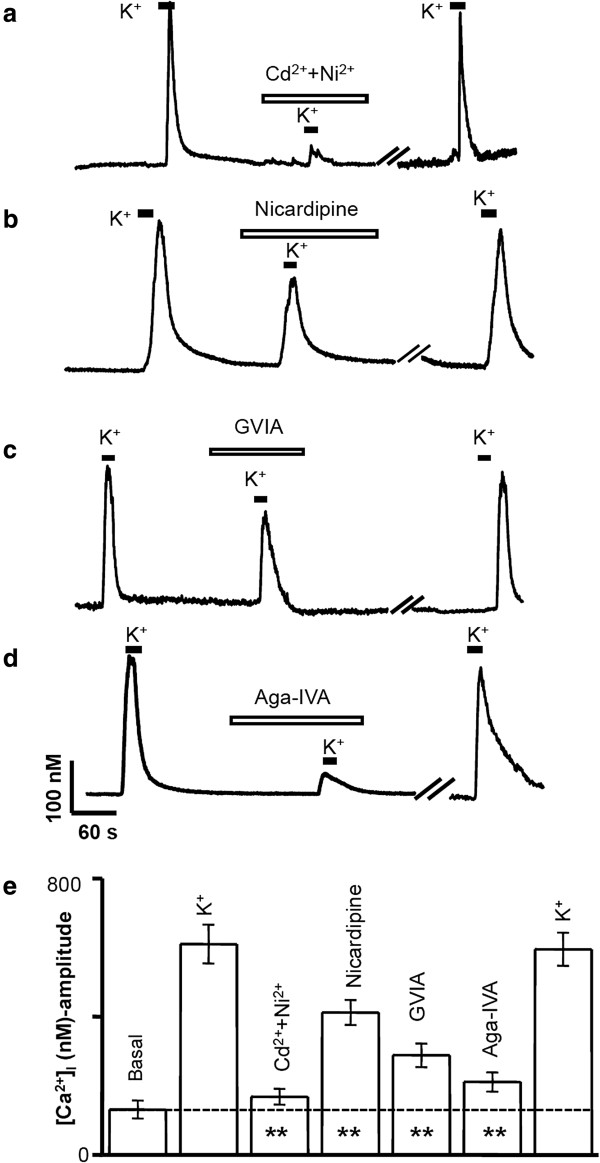
SPC-01 generates functional neurons. (a) Preincubation with Cd2+ (100 μM) together with Ni2+ (50 μM), for 5 minutes significantly reduced the [Ca2+]i responses induced by K+ in all cells tested by 93% ± 9.2% (n = 5), indicating the involvement of voltage-activated Ca2+ channels in depolarization-induced Ca2+ entry. (b) The specific L-type Ca2+ channel blocker nicardipine (1 μM) reduced the [Ca2+]i responses by 28% ± 7% (n = 5; P = 0.002). The trace in (c) shows the [Ca2+]i responses observed in a selected SPC-01-derived neuron induced by 50 mM K+, preincubated for 2 minutes with Ω -GVIA (800 nM) and then stimulated with K+. After a washout of 10 minutes, the same cells were subjected to K+ to observe recovery. Similarly, the effect of the P/Q-Ca2+ channel blocker, Ω -Aga-IVA, 300 nM was tested before and during stimulation with high K+(d). After washout of the toxin, the [Ca2+]i response was shown to be reversible. The histogram (e) summarizes the results presented in (c) and (d). The resting [Ca2+]i level in these cells is indicated as basal. The results are expressed as mean ± SEM; n = 4 (Ω-GVIA) and n = 5 (Ω-Aga-IVA). Asterisks indicate the statistical significance (P > 0.05) versus control K+ stimulus.